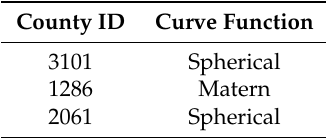
Table 4. Spatial Structure by